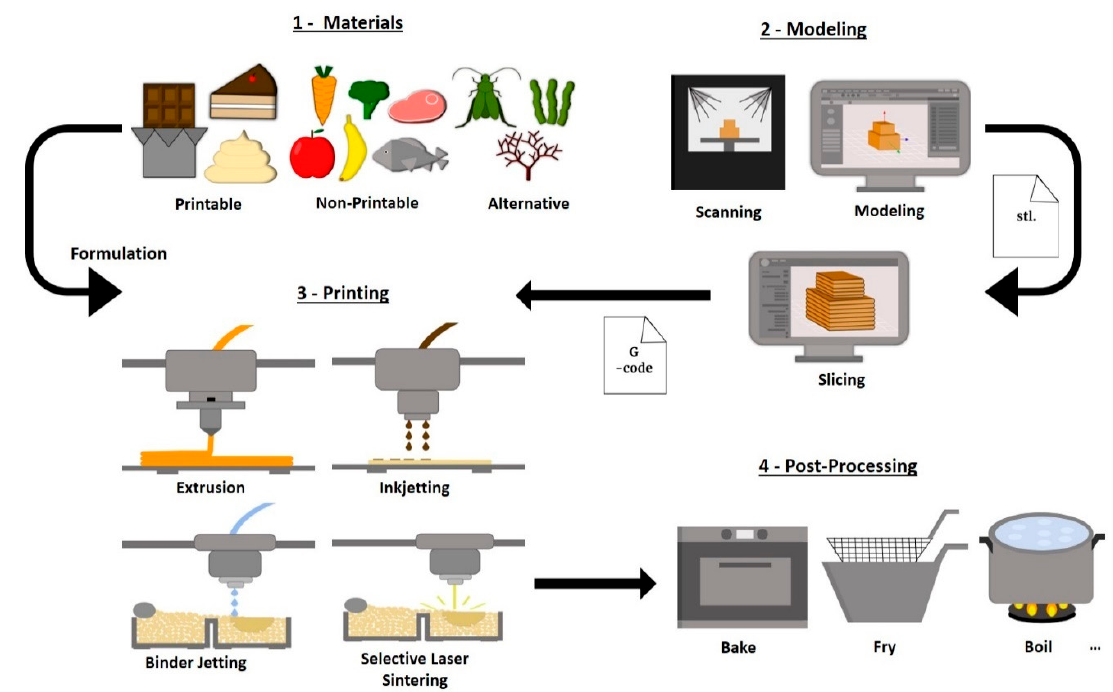
Figure 2. Schematic of the 3D food printing process. Table 1. Some advantages and limitations of using 3D Printing for food